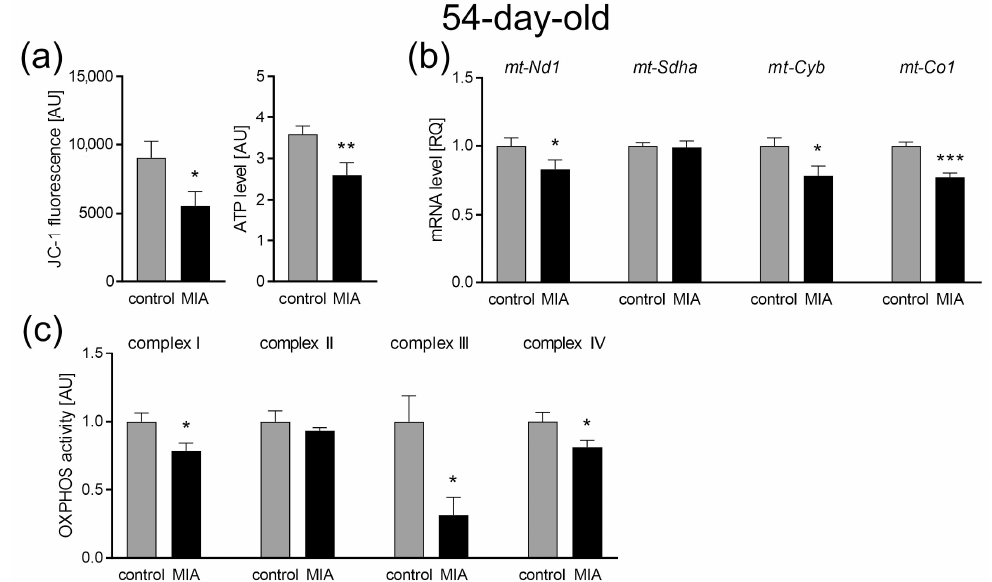
Figure 8. The effect of MIA on mitochondrial function in the brain of 54-day-old MIA offspring. ( a ) Mitochondrial membrane potential was determined by the fluorometric method using JC-1 (n = 5 and 9) and the mitochondrial ATP level was determined using the bioluminescence assay (n = 9 and 11). ( b ) The levels of mRNA for four mitochondrial electron transport chain complexes were analyzed by real-time PCR using Actb as a reference gene for mt-Nd1 (n = 5), mt-Sdha (n = 5 and 4), mt-Cyb (n = 4), and mt-Co1 (n = 4). ( c ) The activity of the respiratory complexes was measured using the kinetic spectrophotometric method: complex I (n = 7), complex II (n = 5 and 4), complex III (n = 5 and 4), and complex IV (n = 6 and 8). Data represent the mean value ± S.E.M. and were analyzed using Student’s t -test. * p < 0.05, ** p < 0.01, *** p < 0.001, compared with the control group.